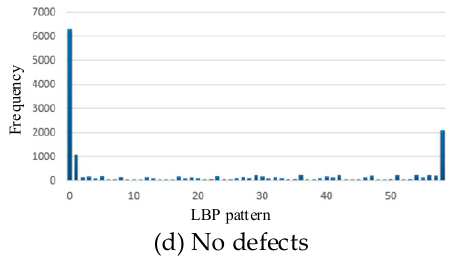
Figure 9. 59-dimensional histogram of LBP patterns: scratches ( a ), slags ( b ), peels ( c ), no defects ( d ).